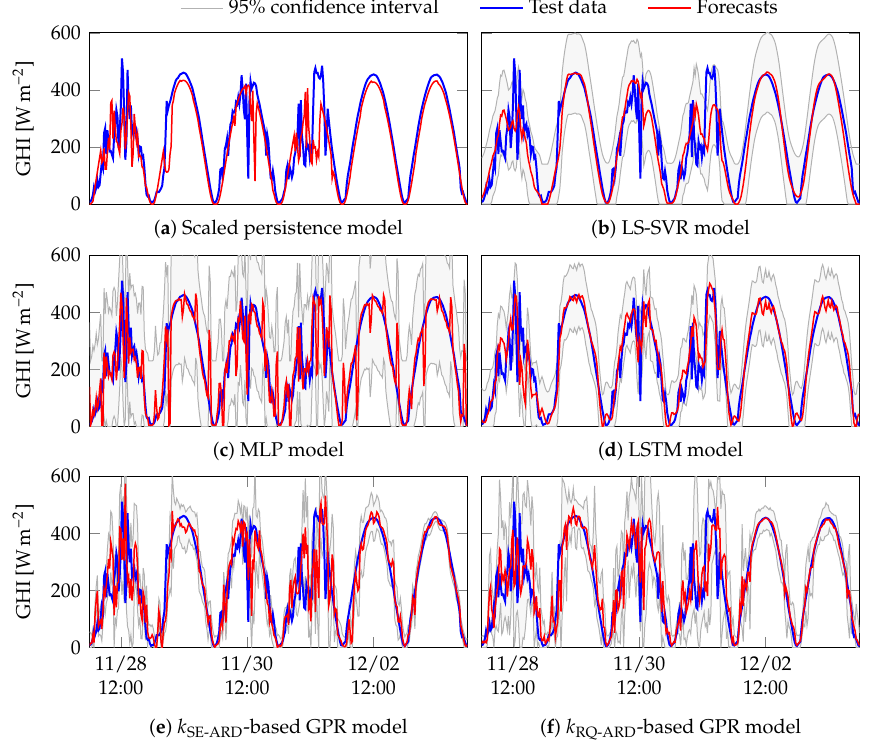
Figure 9. Examples of 1h forecasts of GHI given by the models included in the comparative